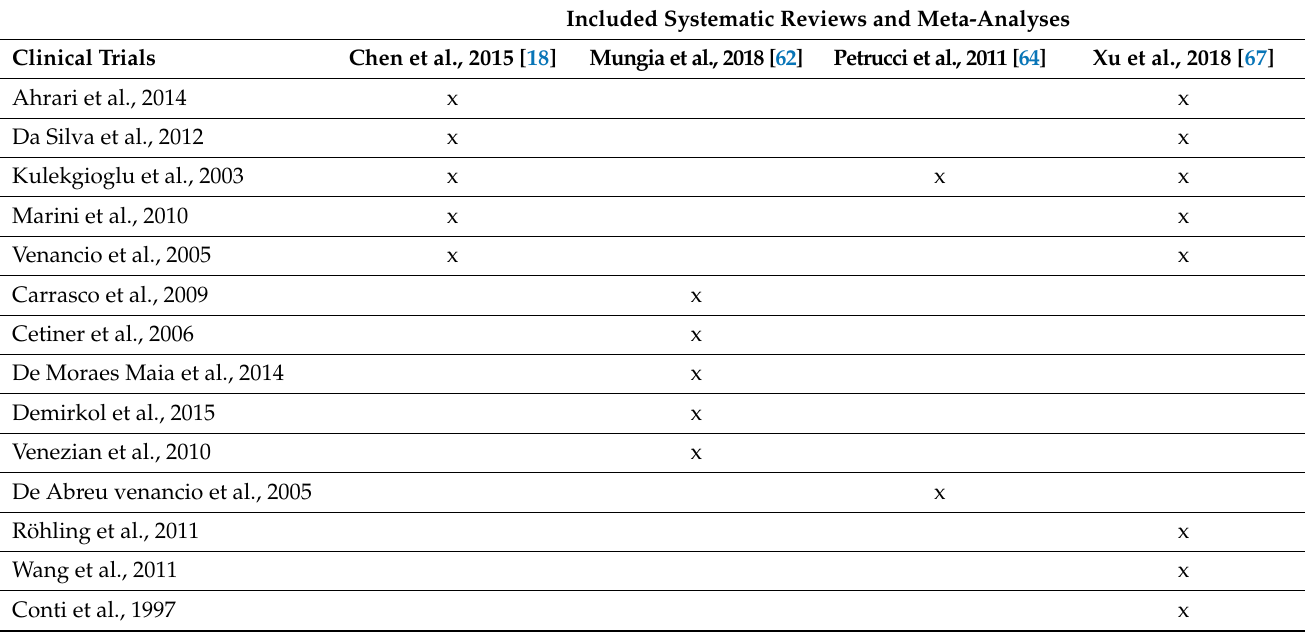
Table A7. Overlap of clinical trials of the MMA of LLLT interventions on mouth